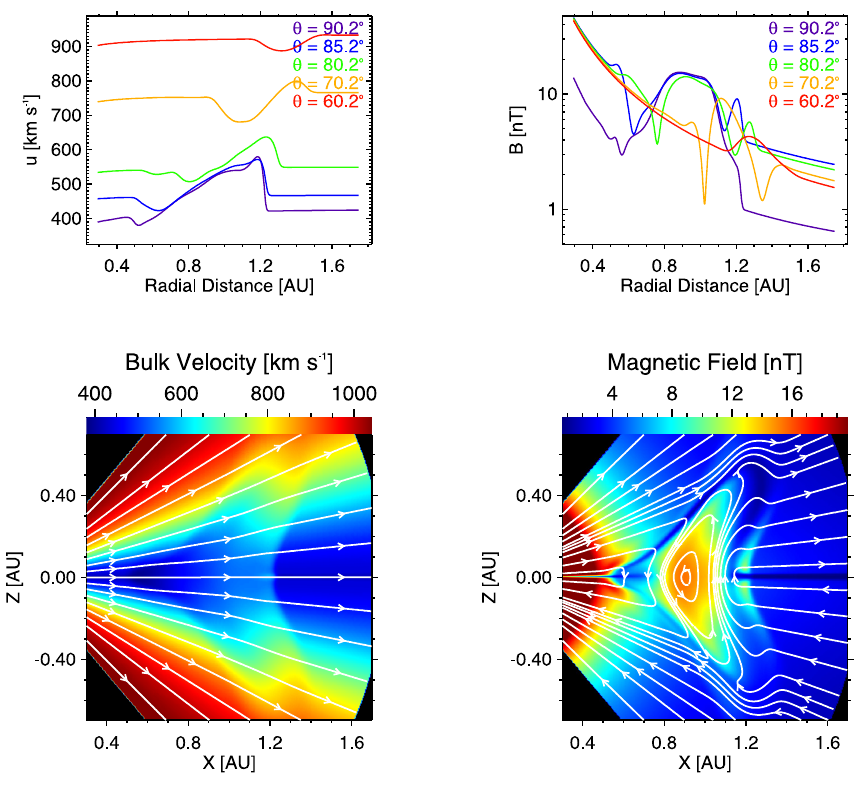
Fig. 12. Velocity (left) and magnetic field (right) for the H + m magnetic cloud near Earth (MC-center at ∼